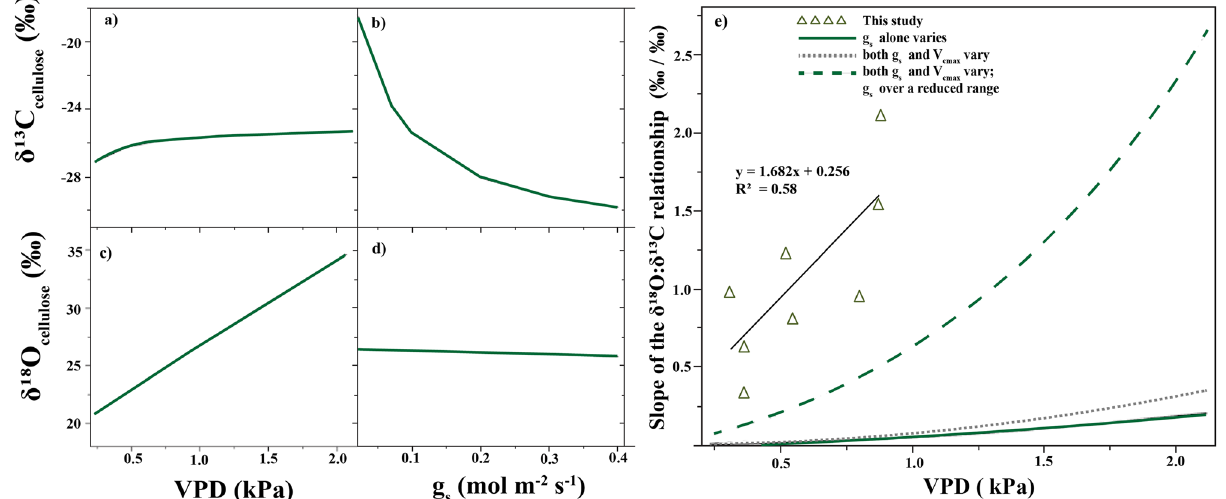
Figure 2. Summary output of mechanistic models developed to describe a causal relationship between VPD and δ 18 O:δ 13 C slopes in tree-ring cellulose ( a – d ) and in relation to our own observations of modern trees across biomes ( e ). Modeled δ 18 O and δ 13 C ratios are calibrated for Pinus radiata trees when: ( a ) and ( c ) vapour pressure deficit (VPD) varies; ( b ) and ( d ) stomatal conductance ( g s ) varies, under constant source water (δ 18 O at − 8.0‰; model adapted from Barbour et al. 8 ). Air temperature was kept constant at 20 °C, and stomatal conductance ( g s ) varied between 0.02 and 0.48 mol m −2 s −1 . Photosynthetic capacity ( V cmax ) at the given temperature varied between 24 and 34 mmol m −2 s −1 ; V cmax variation alone showed little influence on δ 18 O and δ 13 C 8 . Model defaults were vapour pressure deficit = 0·94 kPa, g s = 0.19 mol m −2 s −1 (on a projected leaf area basis) and V cmax = 30 mmol m −2 s −1 and constant source water δ 18 O of – 8.0‰. ( e ) Shows the modeled relationships between vapour pressure deficit (VPD) and the change in slope of the δ 18 O and δ 13 C relationship when variation in δ 13 C is driven by changes in g s alone, or by large changes in both g s and V cmax , or by small variation in g s and large variation in V cmax . We plotted our compiled global observations (triangles) of cellulose δ 18 O:δ 13 C slopes and annual average VPD in contemporary needle-bearing taxa from around the world which showed a positive and significant relationship between δ 18 O and δ 13 C (Table S5). For ease of comparison with the Barbour et al. model 8 , here we plotted our modern cellulose data to show δ 18 O:δ 13 C slopes ( S -1 ), whereas δ 13 C:δ 18 O slopes ( S ) are used as previously suggested for paleo-VPD estimates (see Methods for